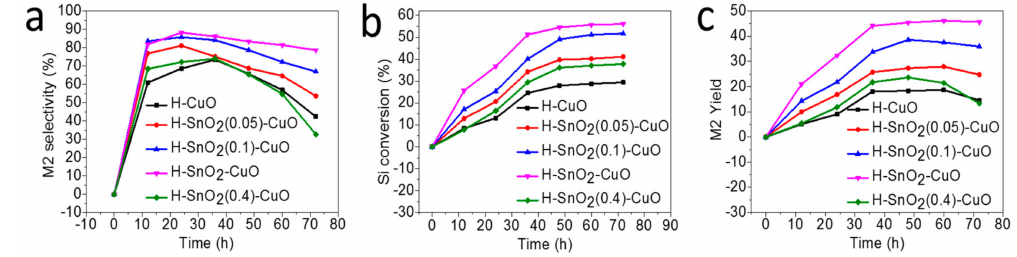
Figure 7. Stability of H-CuO and various H-SnO 2 -CuO samples: ( a ) M2 selectivity; ( b ) Si conversion; and ( c ) M2 yield. Reaction conditions: temperature, 325 ◦ C; catalyst, 0.5 g; Si, 10 g; gas flow: 25